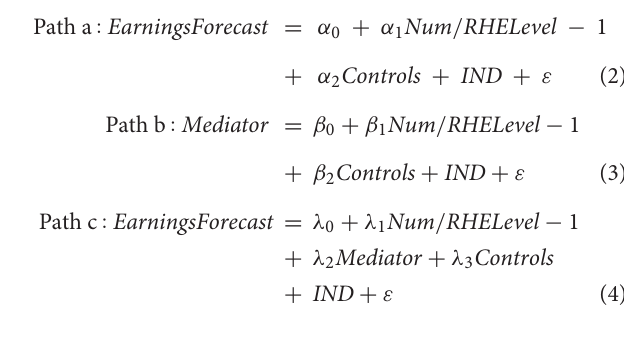
TABLE 3 | Impact of COVID-19 on management’s earnings forecast disclosure. Variable